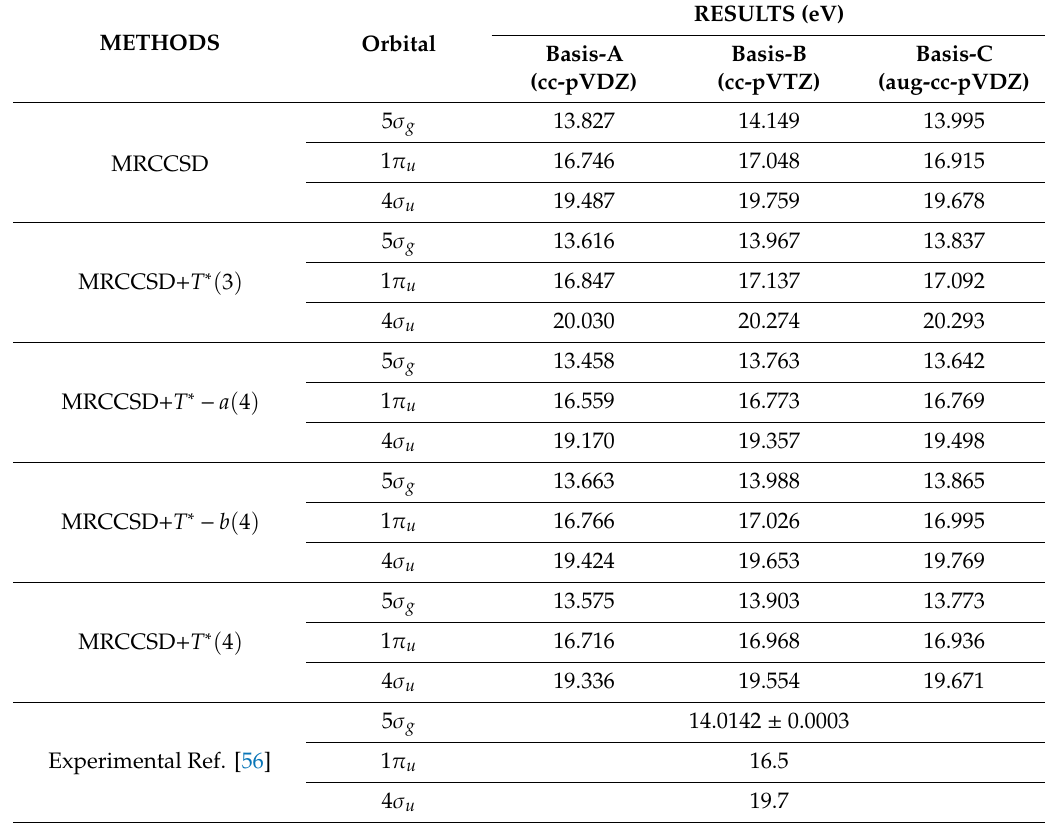
Table 2. Vertical ionization potentials of CO using various basis